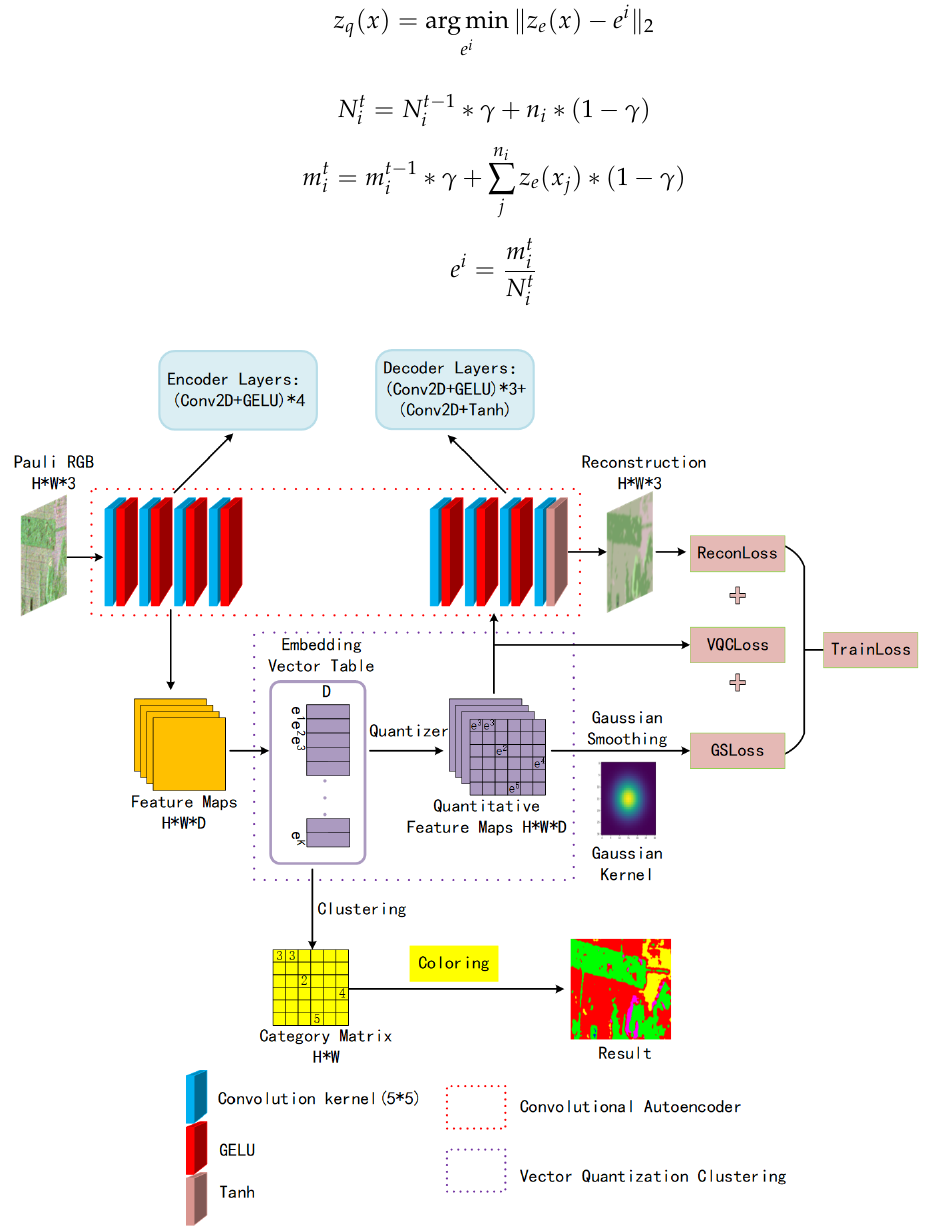
Figure 4. Framework of Vector Quantization Clustering with Convolutional Autoencoder for unsu- pervised PolSAR image classification. The convolutional autoencoder composed of a CNN is shown in the red dashed box, the blue rectangular block represents the two-dimensional convolutional layer Conv 2 D with the size of 5 ∗ 5, the red rectangular block represents the activation function GELU , and the yellow block represents the output layer activation function Tanh . The VQ feature embed- ding is shown in the purple dashed box, the embedding vector table maintains K D -dimensional vectors. After the feature map passes VQ, a quantitative feature feature map and a category matrix are